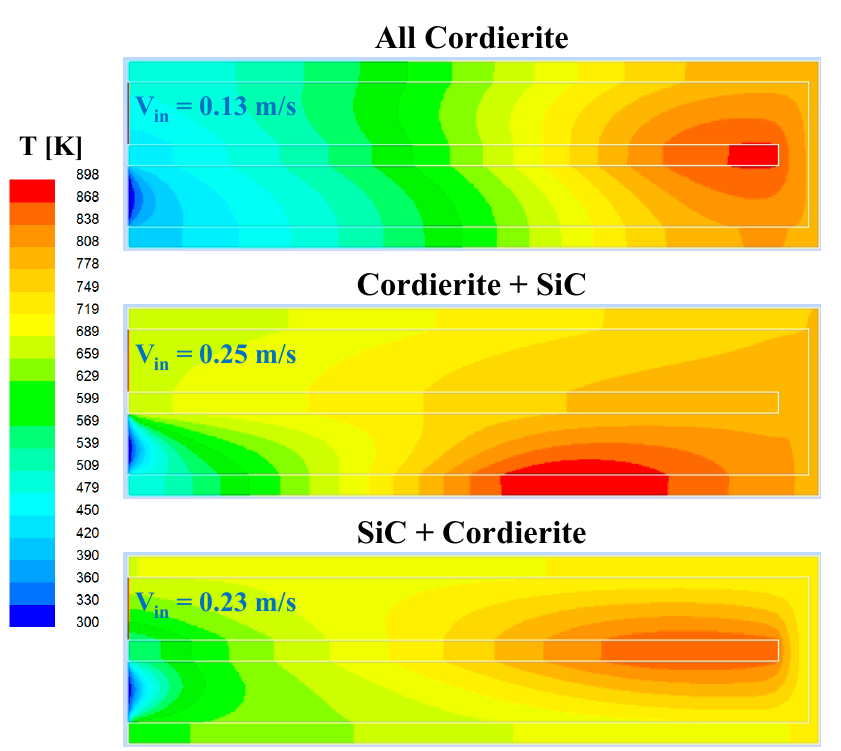
Figure 8. Maps of temperature at extinction: All Cordierite; Cordierite + SiC; SiC + Cordierite. A scaling factor equal to 2 was used to scale the computational domain along the transverse direction.